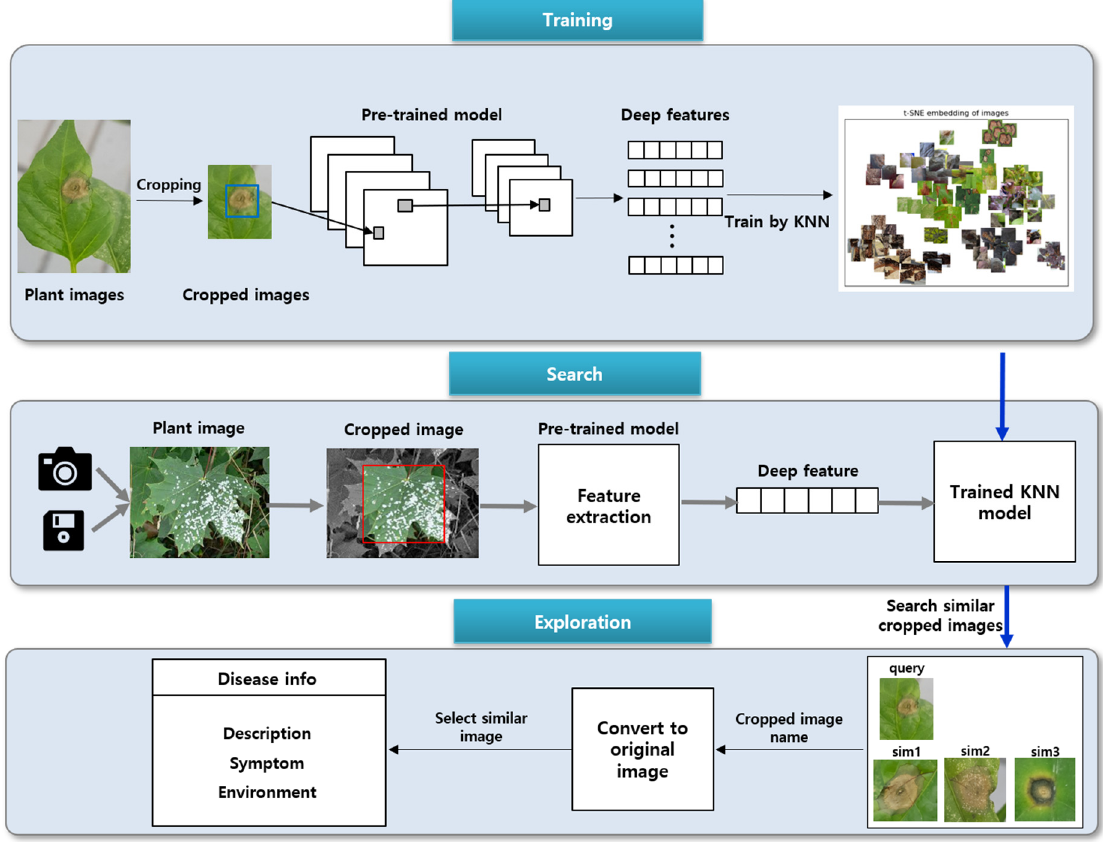
Figure 2. Proposed model’s architecture.